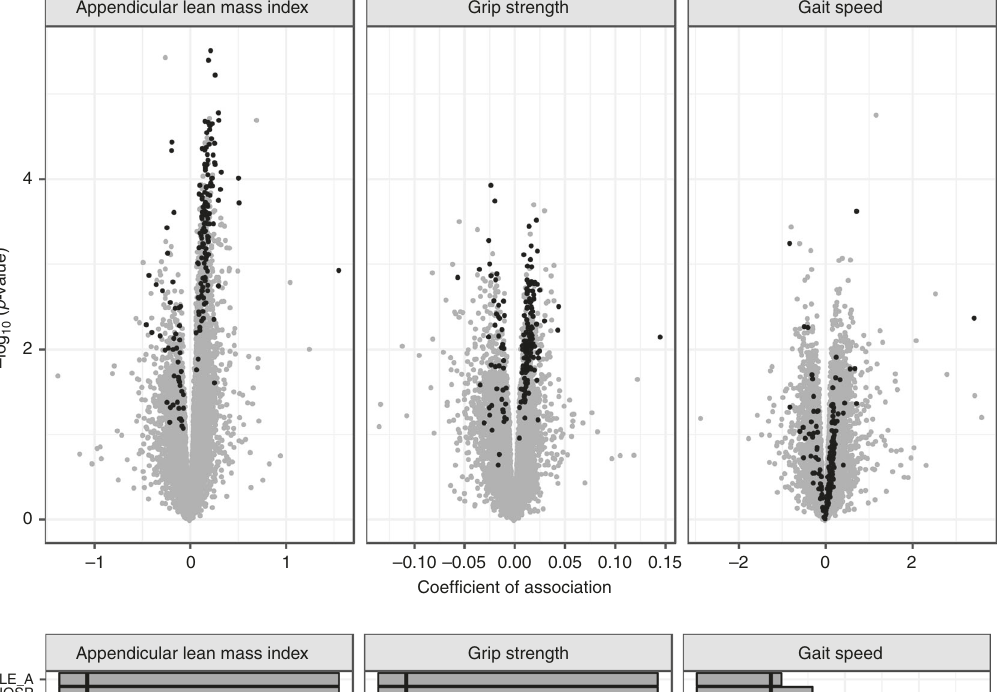
respiratory complexes both at the level of expression and activity. We also detected transcriptional signatures of altered mTOR sig- naling, translation, and protein synthesis in human sarcopenia, consistent with the role of anabolic resistance in the decline of muscle mass and strength during aging 33,34 . In contrast, neuro- muscular dysfunction was not enriched in the transcriptional sig- nature of sarcopenia while high in fl ammatory signaling was